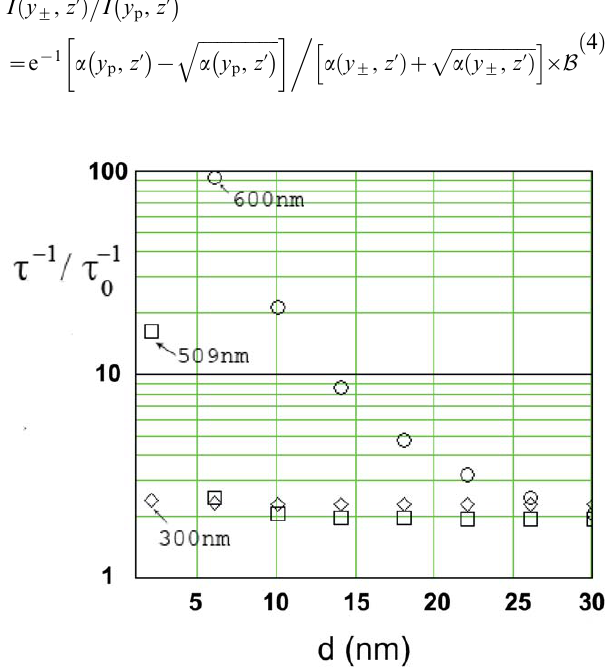
Figure 5. Decay-rate for an oscillating electric-dipole source as a function of dipole-superlens distance. Calculations are shown for three different emission wavelengths ( l 0 , labeled on graph). Parameters are the same as Fig. 4.